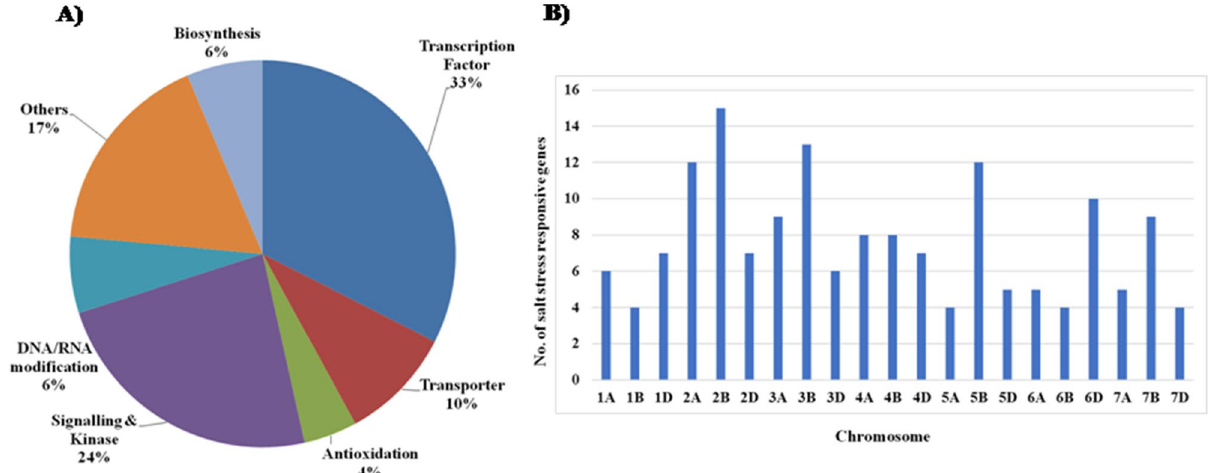
Figure 2. Frequency and distribution of salt stress responsive genes in wheat ( A ) Functional classes of identified salt responsive genes in wheat ( B ) Chromosomal distribution of salt stress responsive genes in wheat. Details of chromosomal location and scaffold regions of salt stress responsive genes were given in Supplementary Table